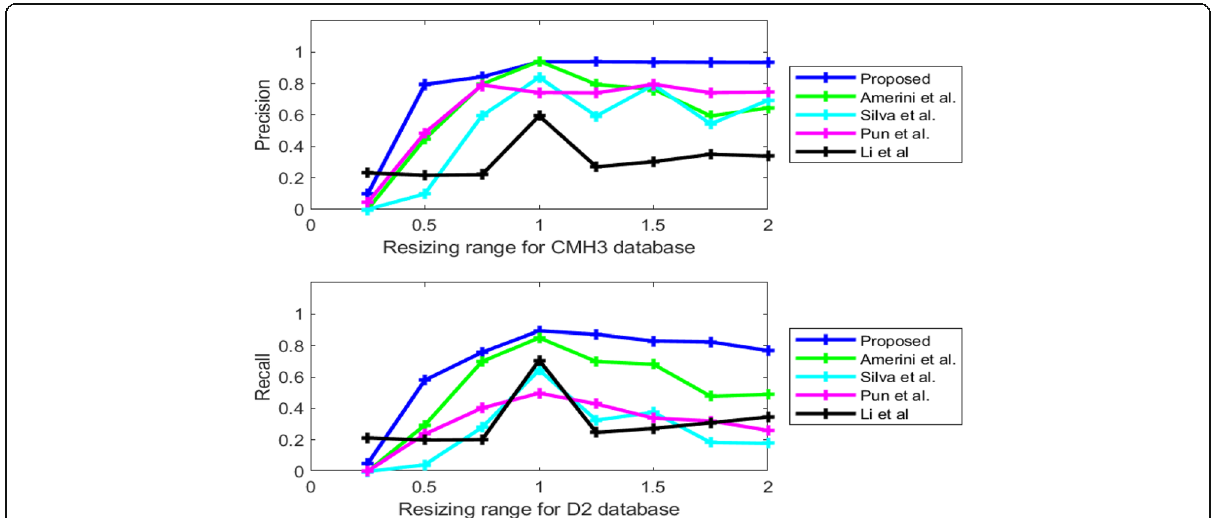
Fig. 13 The precision and recall values under the different resizing ranges compared to our proposed method, and the methods of Amerini et al., Silva et al., Pun et al., and Li et